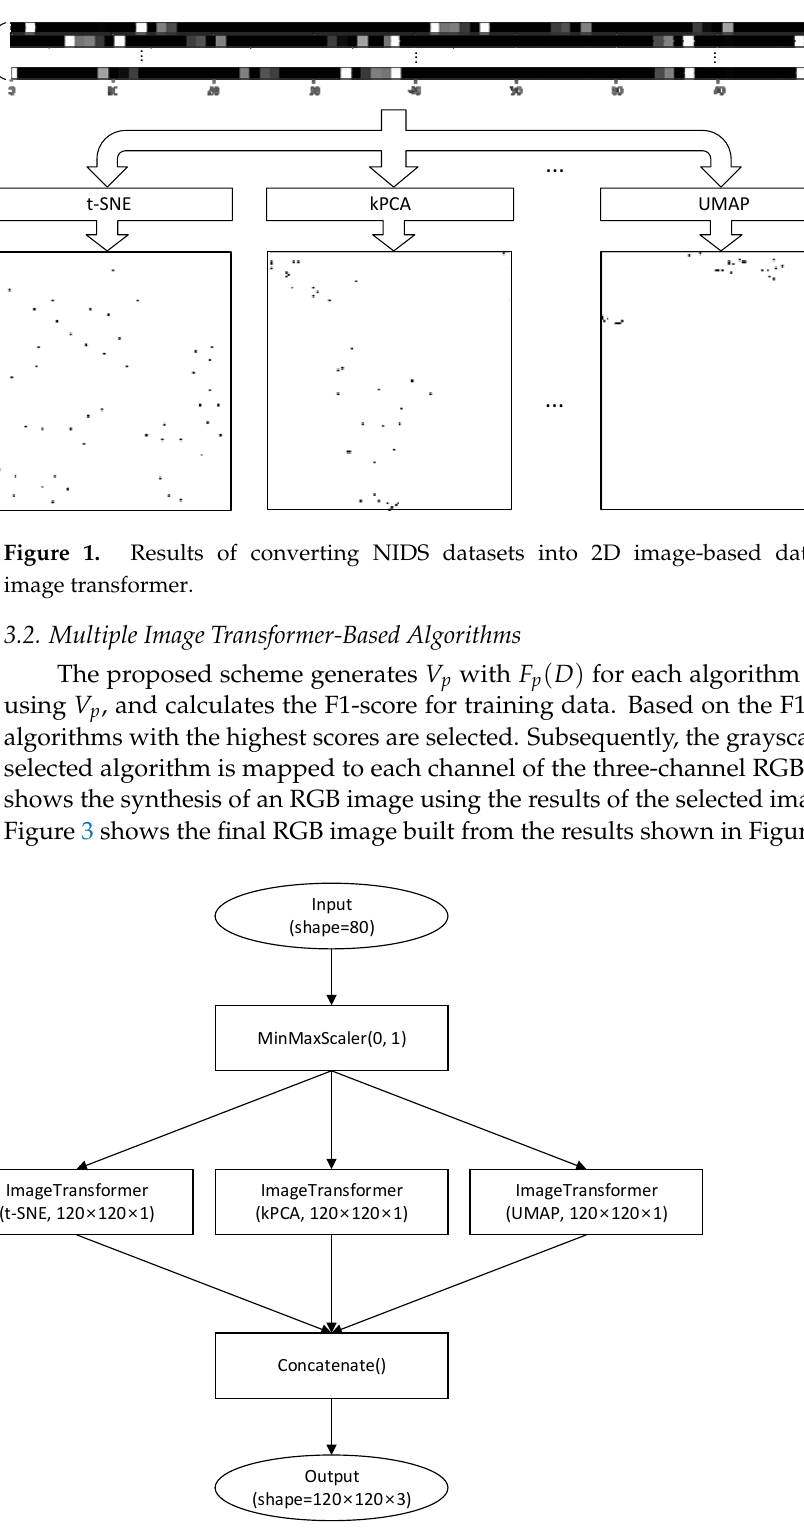
Figure 2. Process of generating a 3-channel RGB color image when t-SNE, kPCA(cosine), or UMAP are selected as the image transformer with the highest F1-score values.